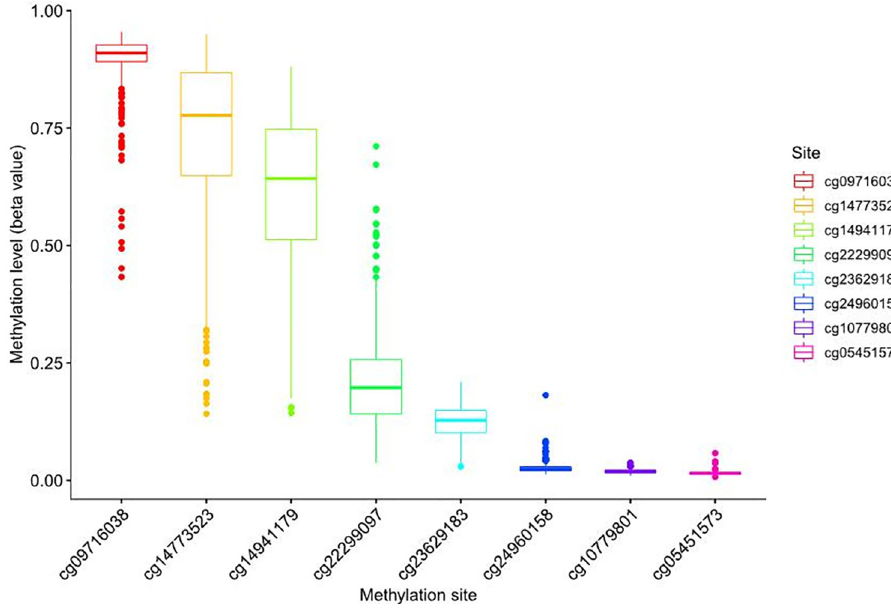
Fig 9. Box plot of methylation levels at RIOX2 gene-related sites in lung squamous cell carcinoma. The abscissa represents RIOX2 related sites, and the ordinate represents site methylation levels.